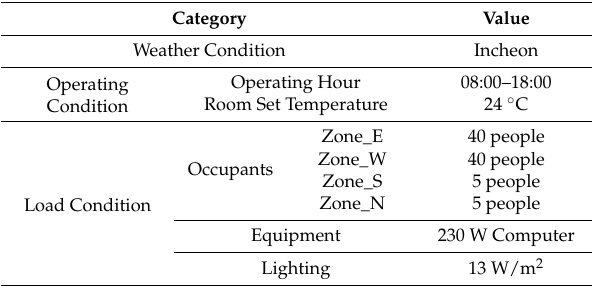
Table 2. Scale of the space. Table 4. Modeling